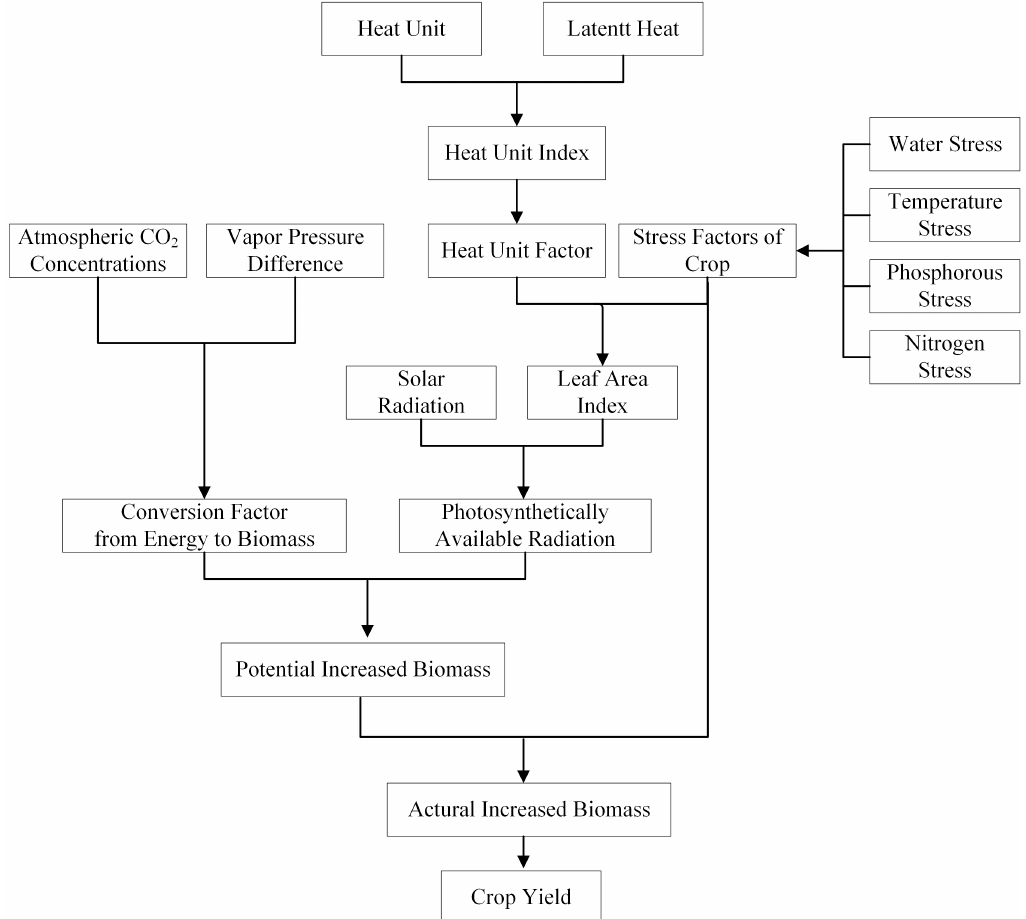
Figure 3. The simulated principle and process of the EPIC crop model.